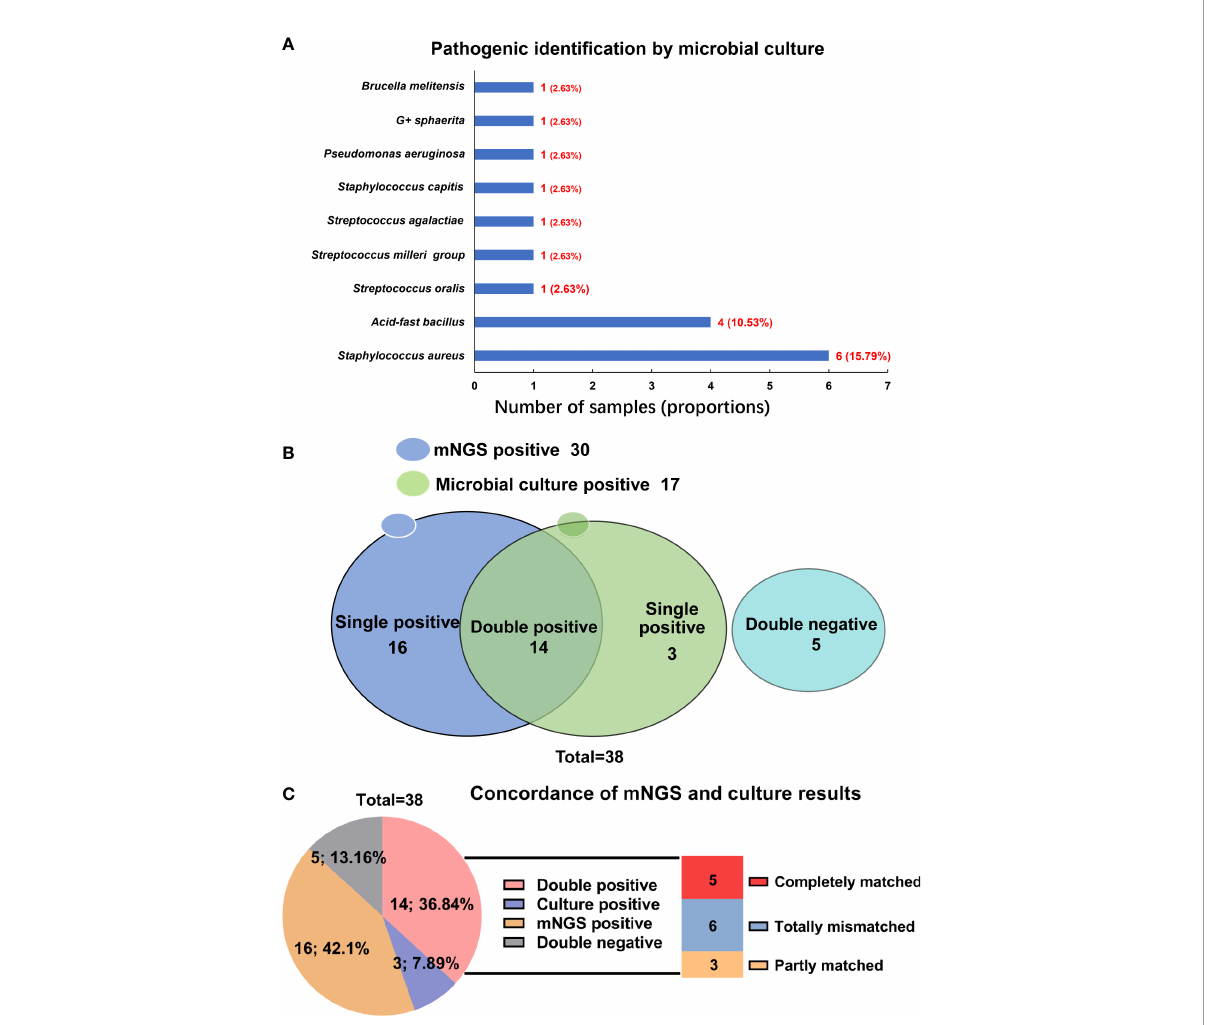
FIGURE 3 Comparison of mNGS and microbial culture in pathogenic identi fi cation in spinal infection. (A) Pathogenic microorganisms identi fi ed by microbial culture; (B) The detecting results of mNGS and microbial culture in different cases; (C) The concordance of mNGS and microbial culture in detecting pathogenic microorganisms.